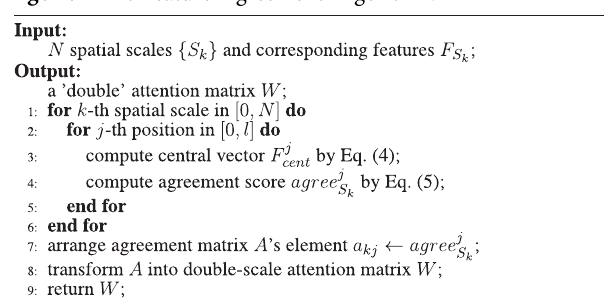
Algorithm 1. Feature Agreement